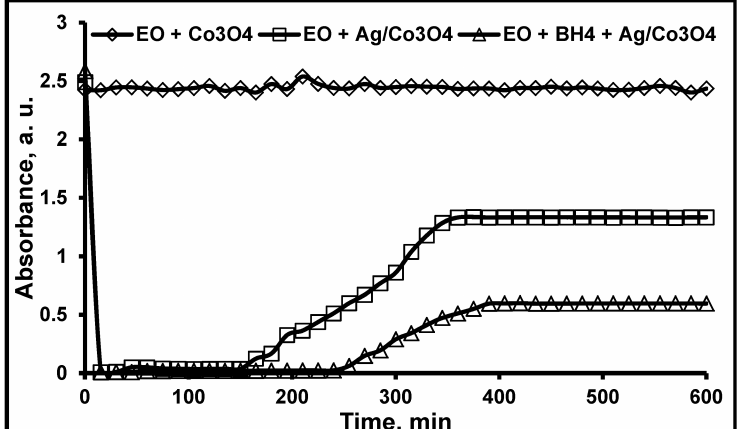
Figure 4. Absorbance (A) vs . time (t) plots of EO reaction studies using SiO 2 -based monolithic catalysts.